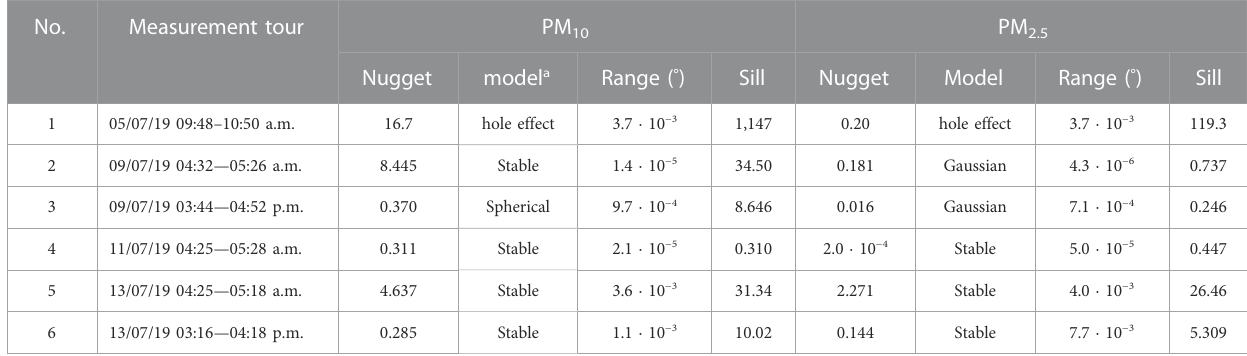
TABLE 3 Model parameters of geostatistical interpolations.